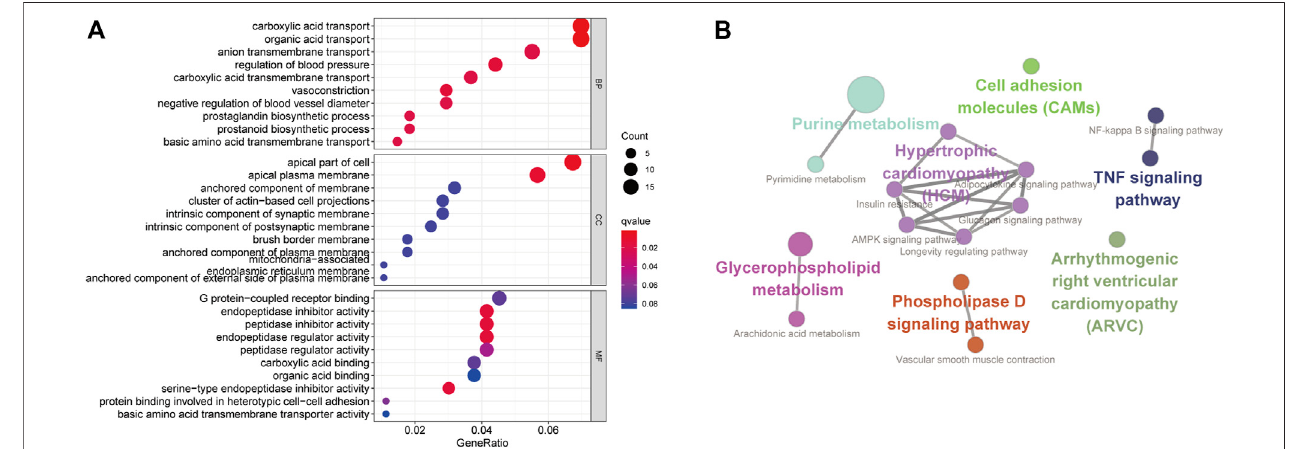
FIGURE 5 | Functionally enriched GO terms and KEGG pathway analysis of DEGs in RIF. (A) BP-associated category, CC-associated category, and MF- associated category of DEMs; DEGs, differentially expressed genes; GO, Gene Ontology; (B) KEGG pathways; KEGG, Kyoto Encyclopedia of Genes and